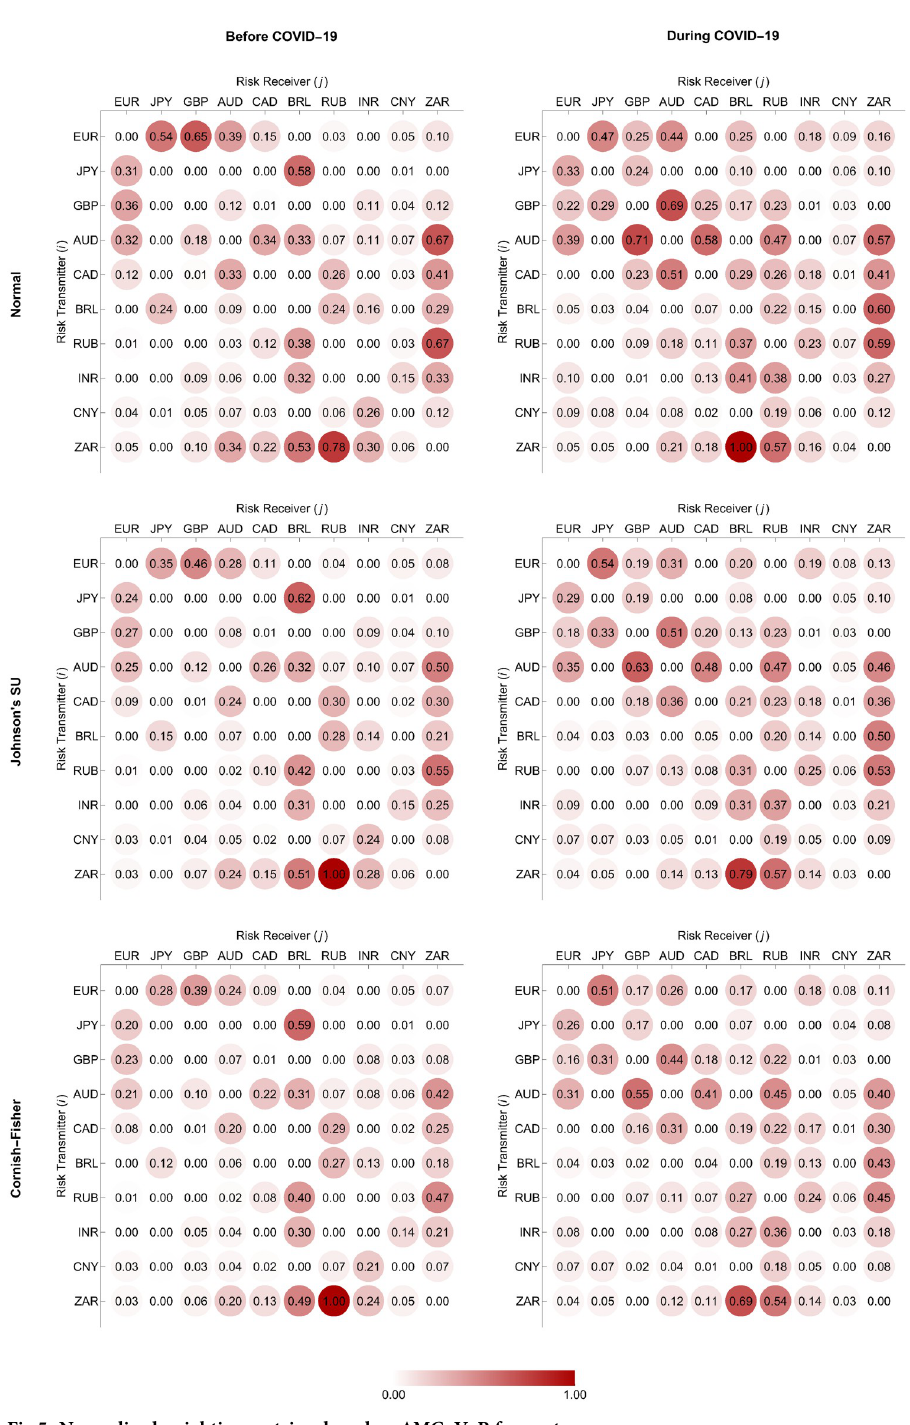
PLOS ONE | https://doi.org/10.1371/journal.pone.0277756 November29,